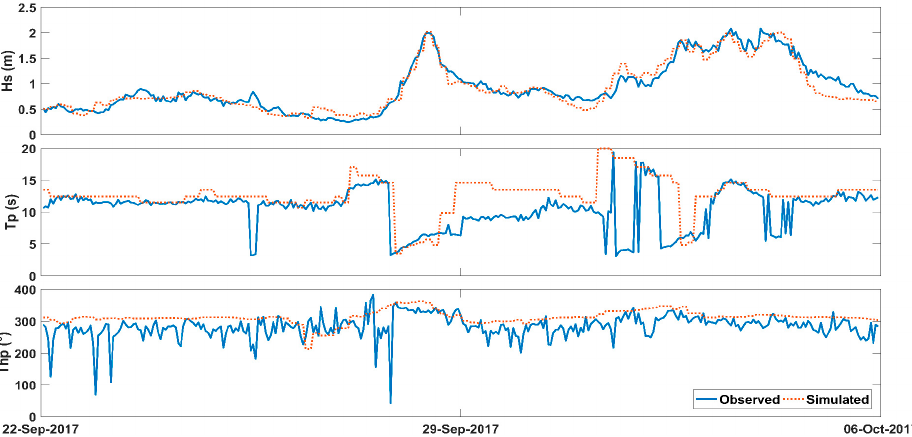
Figure 10. Wave data time series measured with ADCP (blue solid line) and simulated data (orange dashed line).